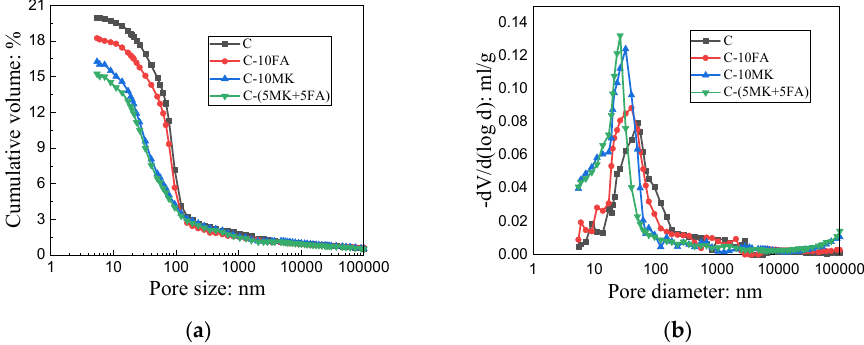
Figure 11. Pore characteristics of MOSC samples after 28 days of curing: ( a ) cumulative volume; ( b ) pore diameter distribution. Table 4. Pore characteristics of MOSC at 28 days.